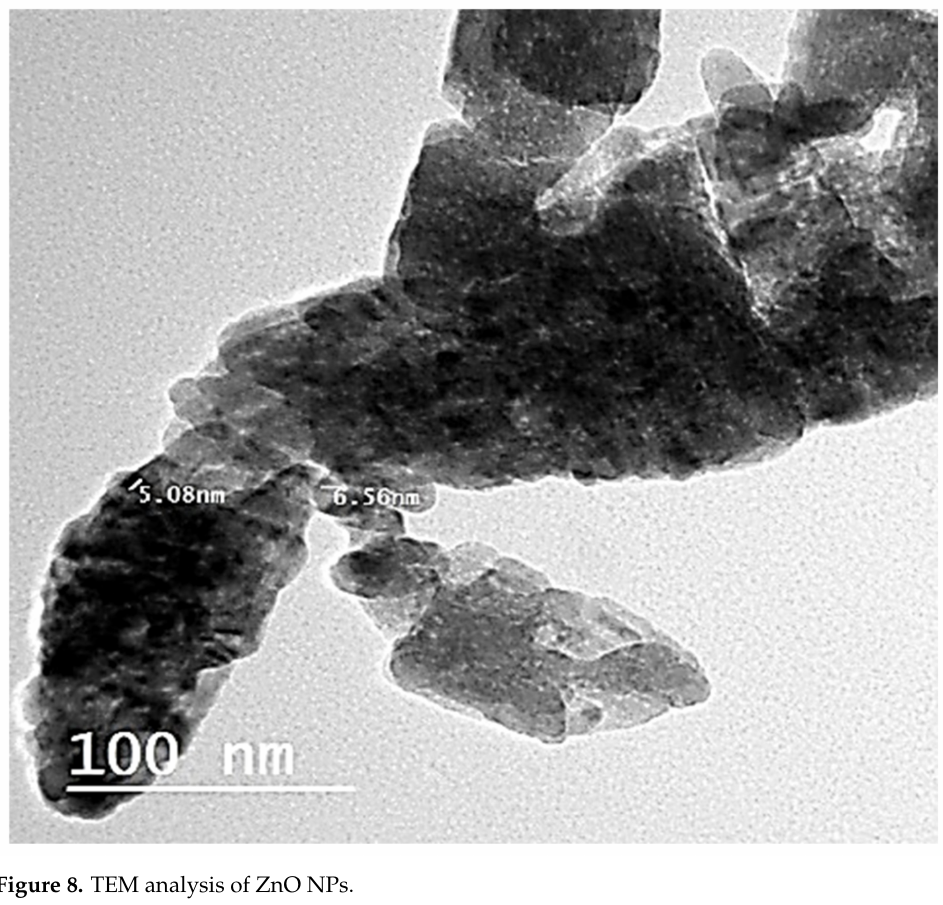
Figure 8. TEM analysis of ZnO NPs.